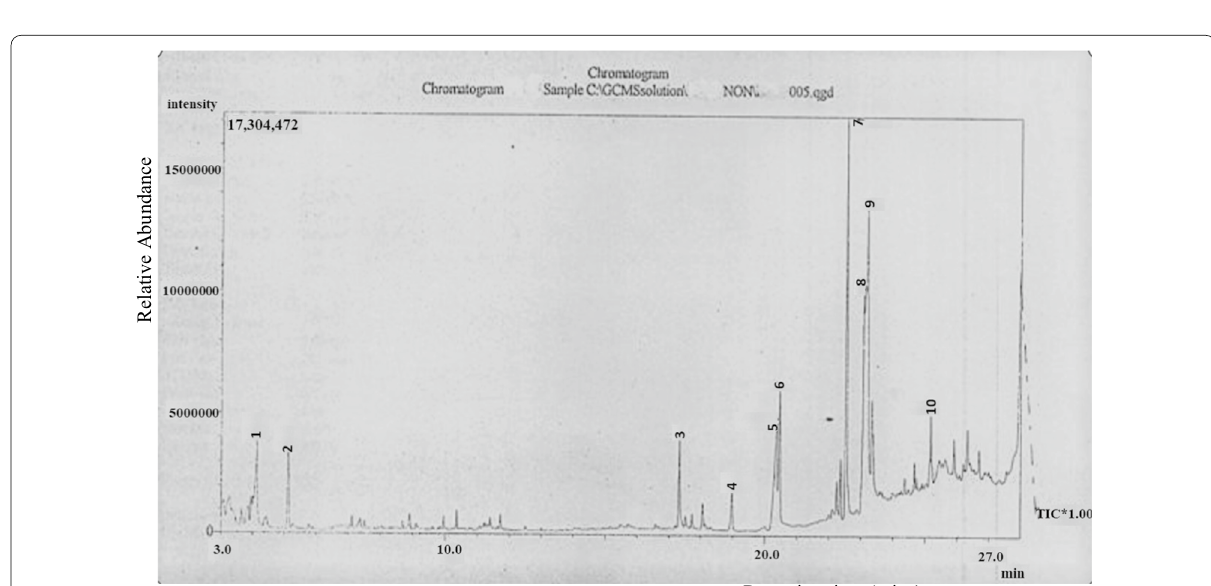
Fig. 2 Bioactive compounds in Ethanol Extract of Vernonia